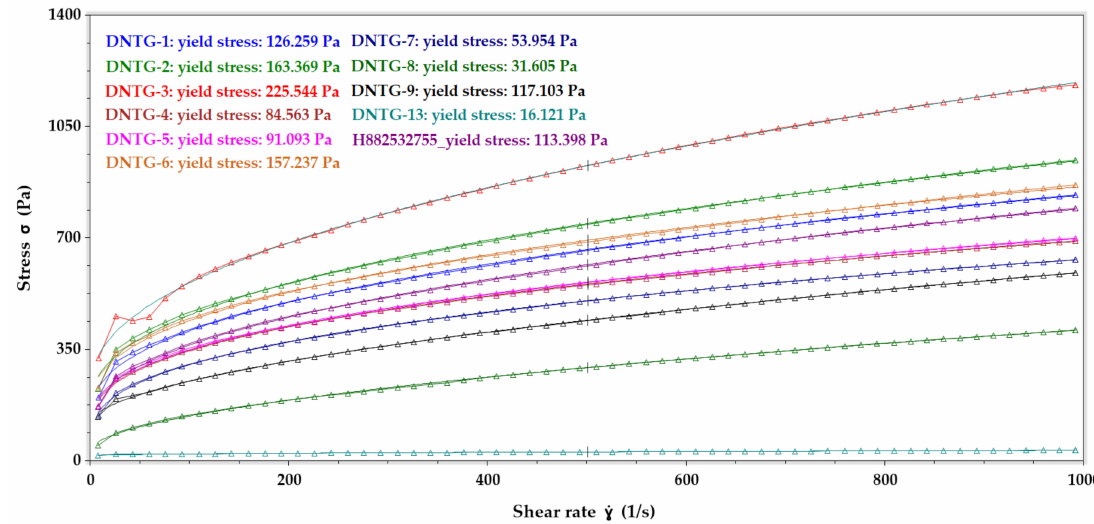
Figure 2. Yield stress (Herschel–Bulkley model) rheological data comparison between DNTG-1 to DNTG-9, DNTG-13 (niosomal gel), and H882532755 (reference